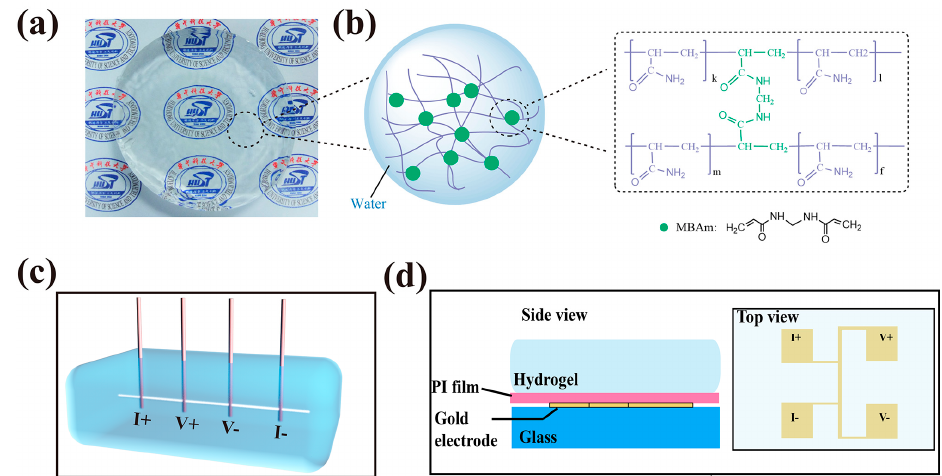
Figure 1. PAAm hydrogel and its experimental setup for thermal conductivity measurement. ( a ) Optical image of the as-prepared PAAm hydrogel sample; ( b ) Schematic of the polymer network with covalent crosslinking through MBAm (green circles) and the molecular structures of the covalently crosslinked polymer chains; ( c ) Schematic of 3 ω method setup for thermal conductivity measurement of hydrogels. A platinum wire is deeply immersed in hydrogels and wired out with four copper probes for applied current and voltage measurements. The four brown rods are copper probes and the white line in hydrogel is the Pt wire; ( d ) Schematic of 3 ω method for thermal conductivity measurement of hydrogels at different water contents and temperatures. The four Au squares (2 mm in length) on a 1 mm thick glass substrate serve as both the heater and thermometer.